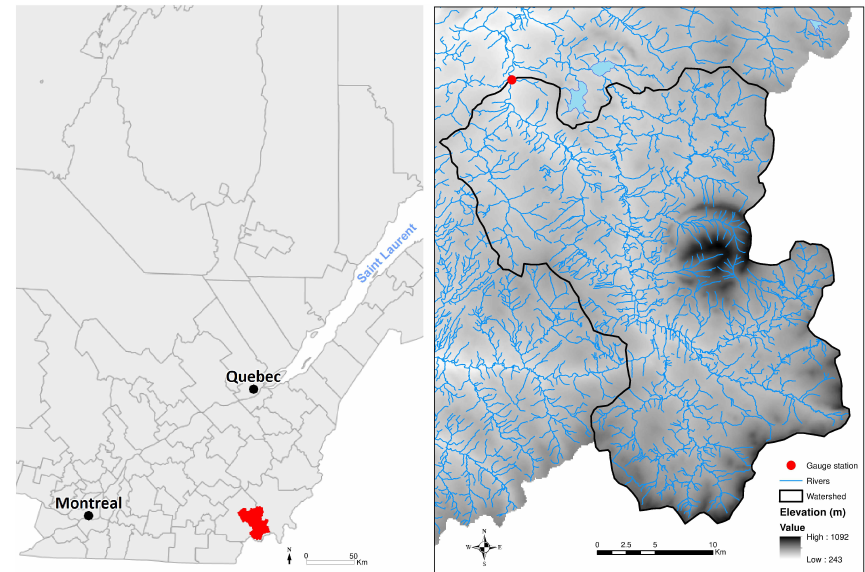
Fig. 1. Location of the Au Saumon catchment (738km 2 ;